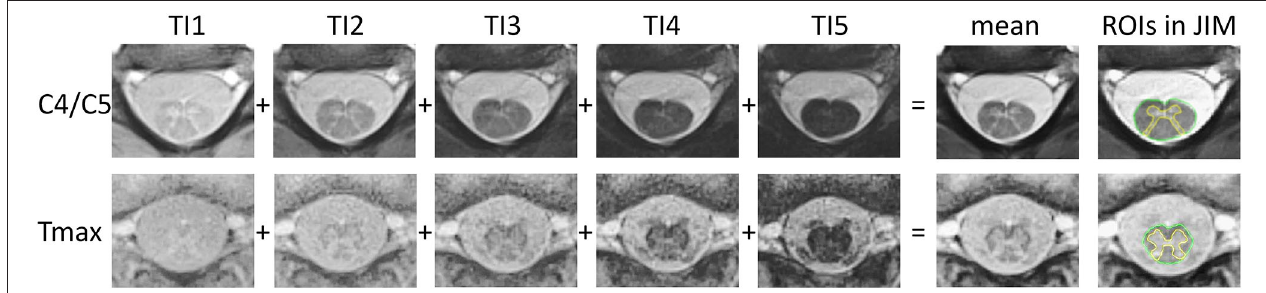
FIGURE 1 | rAMIRA images of the spinal cord in an 11-year-old boy. From left to right: axial rAMIRA images at intervertebral disc level C4/C5 (top row) and T max (bottom row) acquired at five inversion times (TI), mean image (combination of the images at five TIs); and mean images with the region of interests (ROIs) spinal cord total cross-sectional area (TCA, green) and gray matter area (GMA, yellow) which were segmented using the software